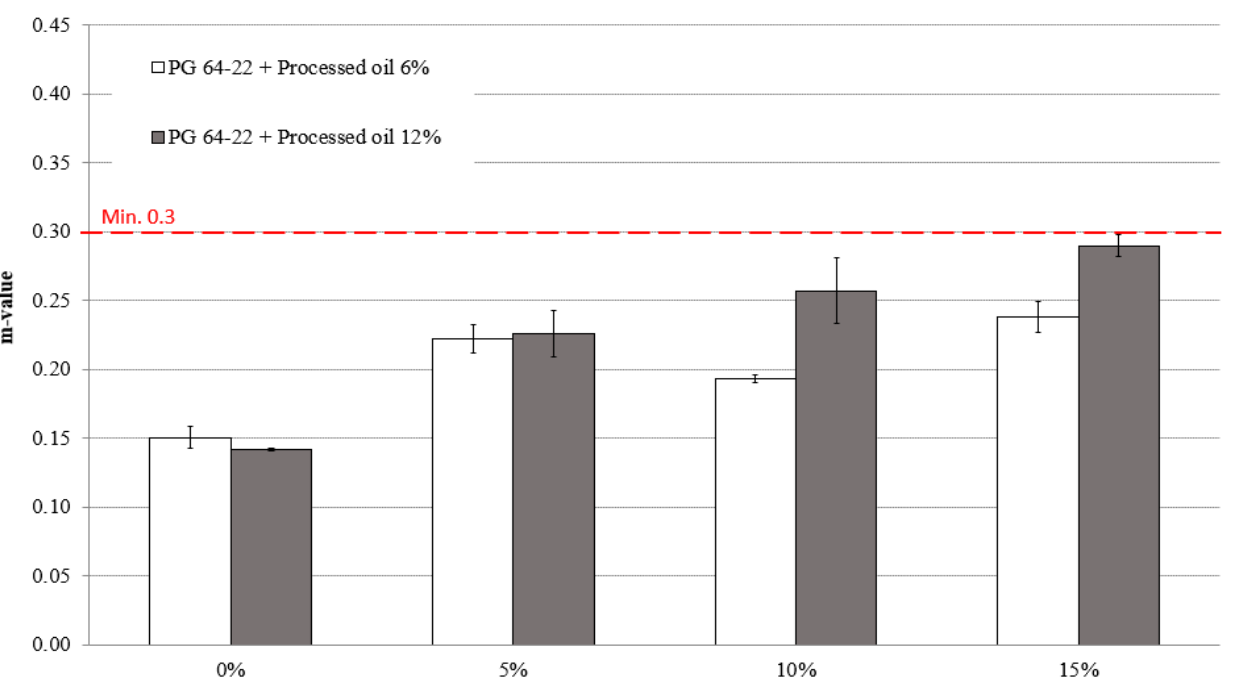
Figure 10. m ‐ value of RTFO + PAV aged PG 64 ‐ 22 binder with processed oil as a function of SBS Figure 10. m-value of RTFO + PAV aged PG 64-22 binder with processed oil as a function of SBS content at − 24 °C. content at − 24 ◦ C. Table 13. Statistical analysis results of m-value for RTFO + PAV aged PG 64-22 with processed oil as a function of SBS content − 12 ◦ C ( α = 0.05).